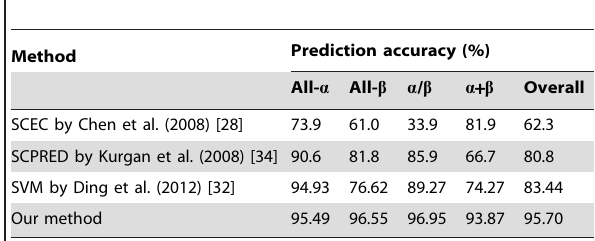
Table 4. Performance comparison of different methods on D640 dataset.